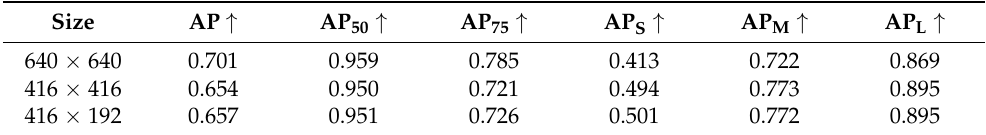
Table 1. Experiment results of different input sizes. “ ↑ ” indicates that the larger the value, the better the performance.